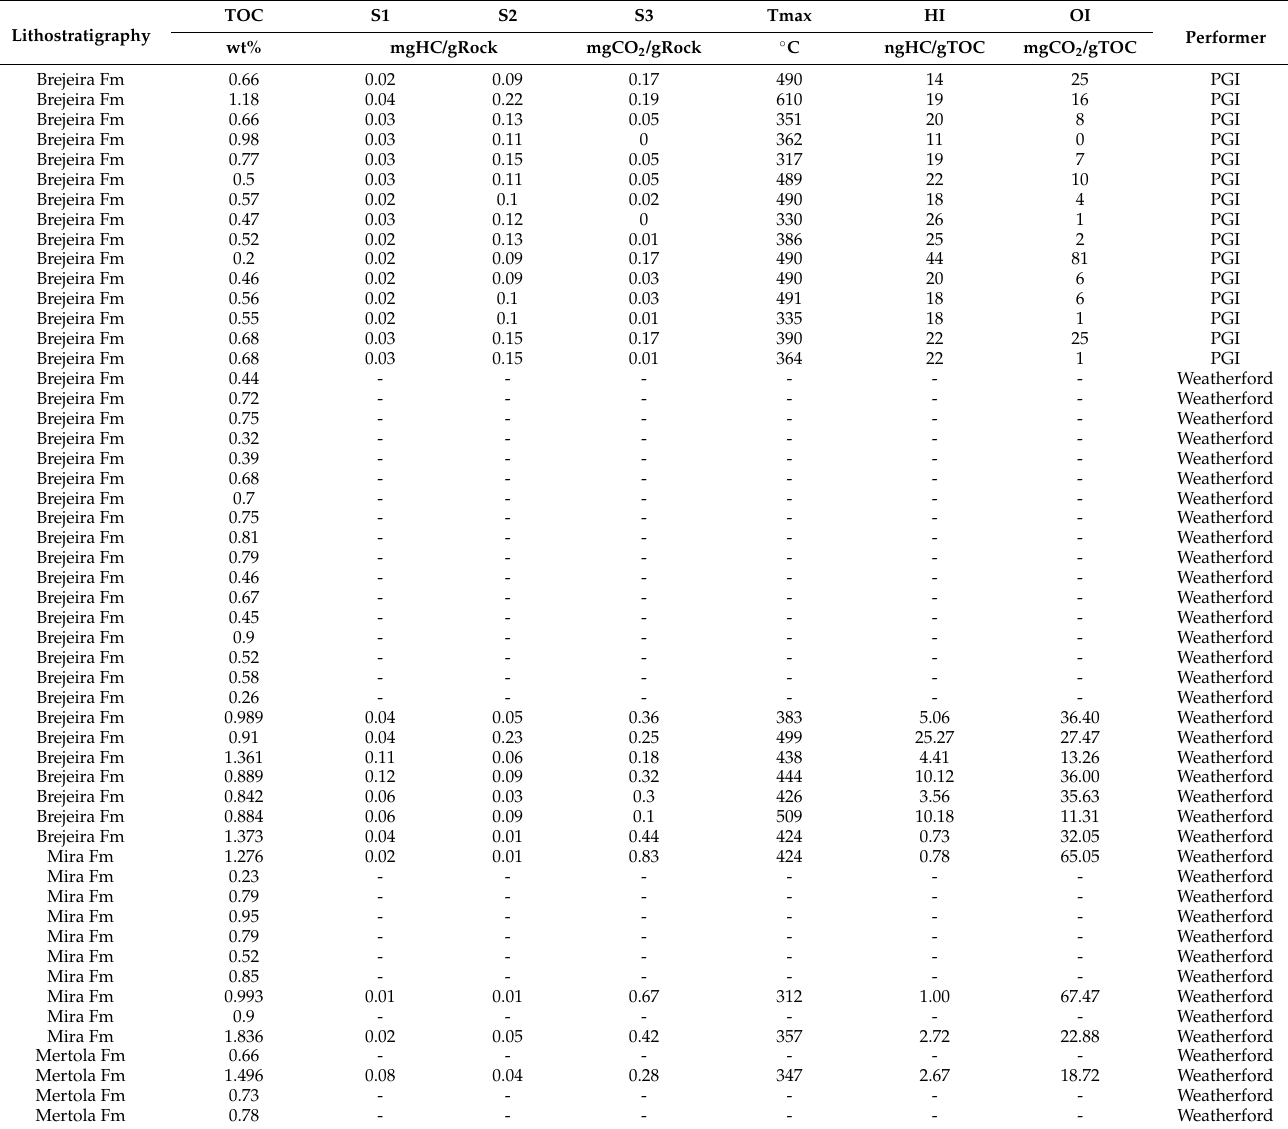
Table 1. Geochemical parameters (TOC and Rock–Eval pyrolysis), from the M é rtola, Mira and Brejeira formation. Weath- erford selected samples with TOC higher than 0.99 wt.% to pyrolyze. Polish Geological Institute (PGI) analyzed all of